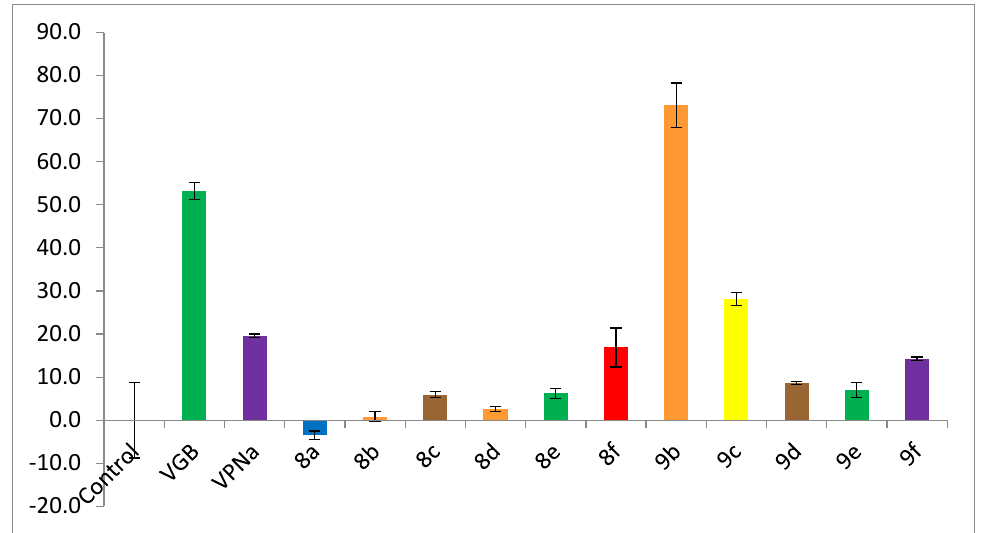
Figure 4. GABA-AT % enzymatic inhibition of compounds 8a – f and 9a – f as compared to VGB and VPNa.